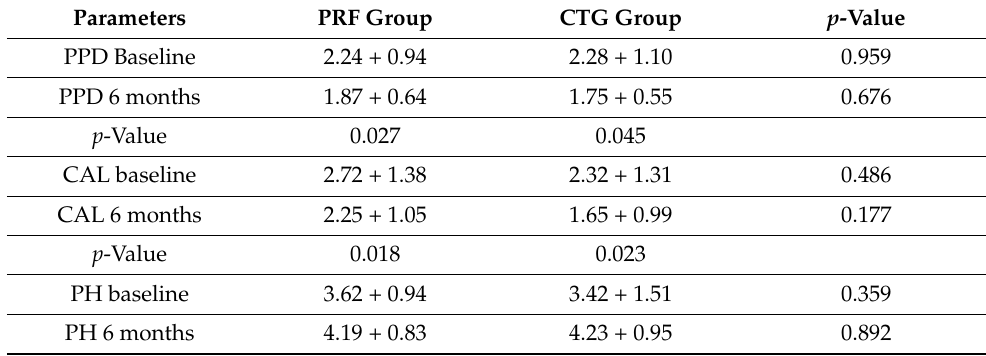
Table 2. Intragroup and intergroup assessment of clinical parameters of the study groups.